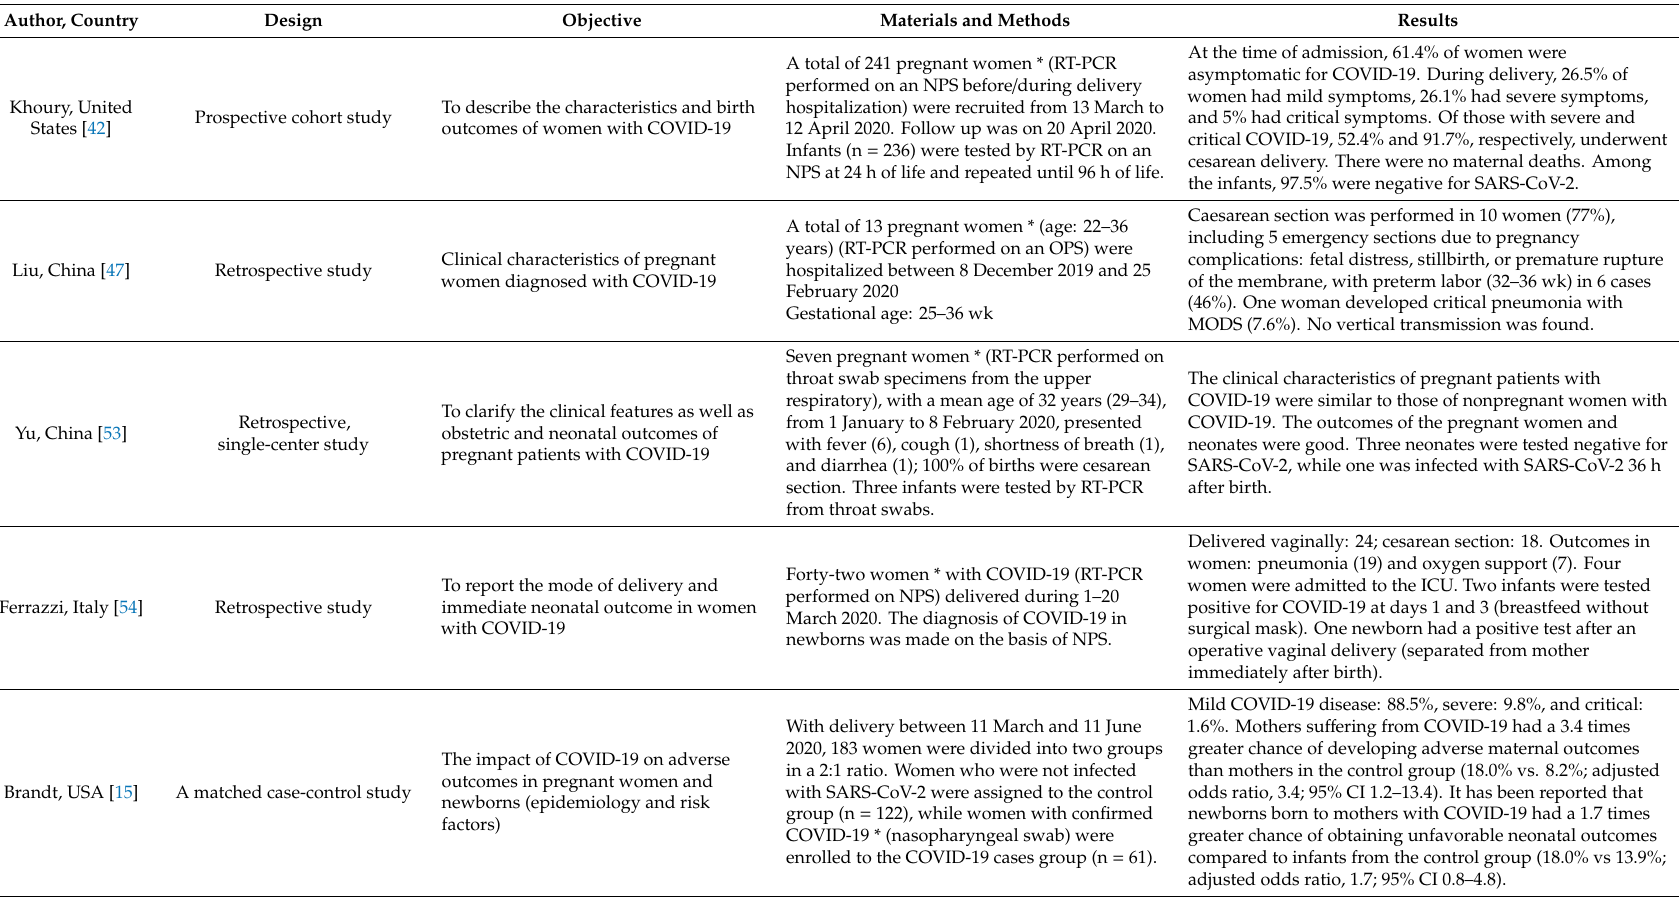
Table 1. Symptoms of Coronavirus Disease 2019 (COVID-19) among pregnant women in prospective, retrospective and case